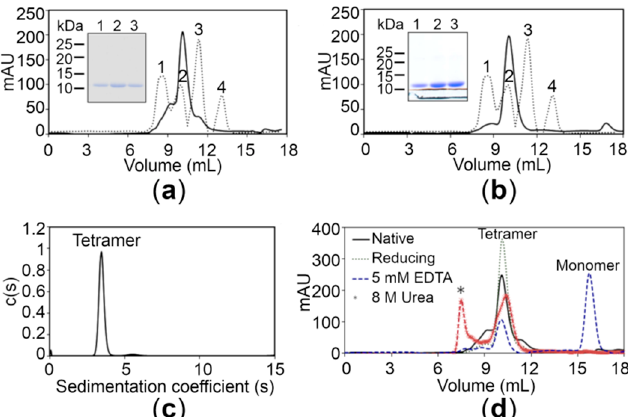
Figure 2. Analysis of the hZnT8 CTDs through gel filtration and analytical ultracentrifugation. ( a , b ) Gel filtration chromatograms of the wild-type (WT) CTD ( a ) and the R325W CTD ( b ) showing an apparent molecular mass of approximately 40 kDa. The dotted lines represent the following protein standards: aldolase (158 kDa) (peak 1), ovalbumin (44 kDa) (peak 2), carbonic anhydrase (29 kDa) (peak 3), and ribonuclease (13.7 kDa) (peak 4). Inset shows the SDS-PAGE analysis of the WT CTD ( a ) and the R325W CTD ( b ) purified by size exclusion chromatography. ( c ) A major peak corresponding to the tetrameric form (39.6 kDa) for the WT CTD obtained using analytical ultracentrifugation. ( d ) Gel filtration chromatograms of the WT CTD with 5 mM ethylenediaminetetraacetic acid (EDTA) (blue dotted lines), 8 M urea (brown dotted lines), and 3 mM β -mercaptoethanol (green dotted lines) are depicted. Protein aggregates formed in the presence of urea are shown with an asterisk